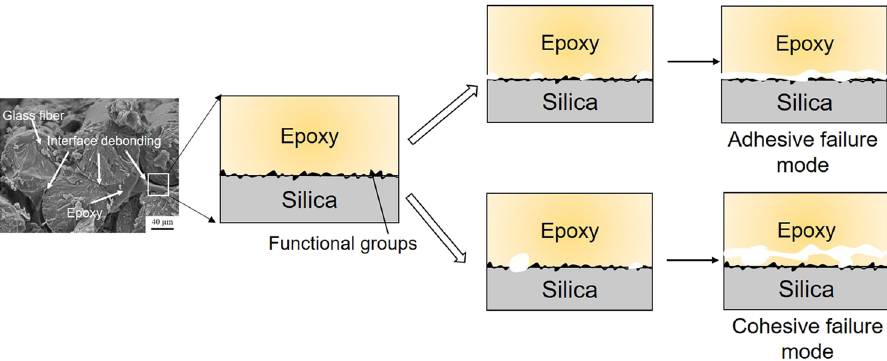
Figure 11: The surface - modi fi ed GFR epoxy composites exhibit two types of interface debonding: adhesive failure mode and cohesive failure mode. The introduction of functional groups signi fi cantly a ff ects the interface failure mode. The strong interfacial interactions between epoxy and silica prevent the debonding at the contact surface between epoxy and silica, leading to a cohesive